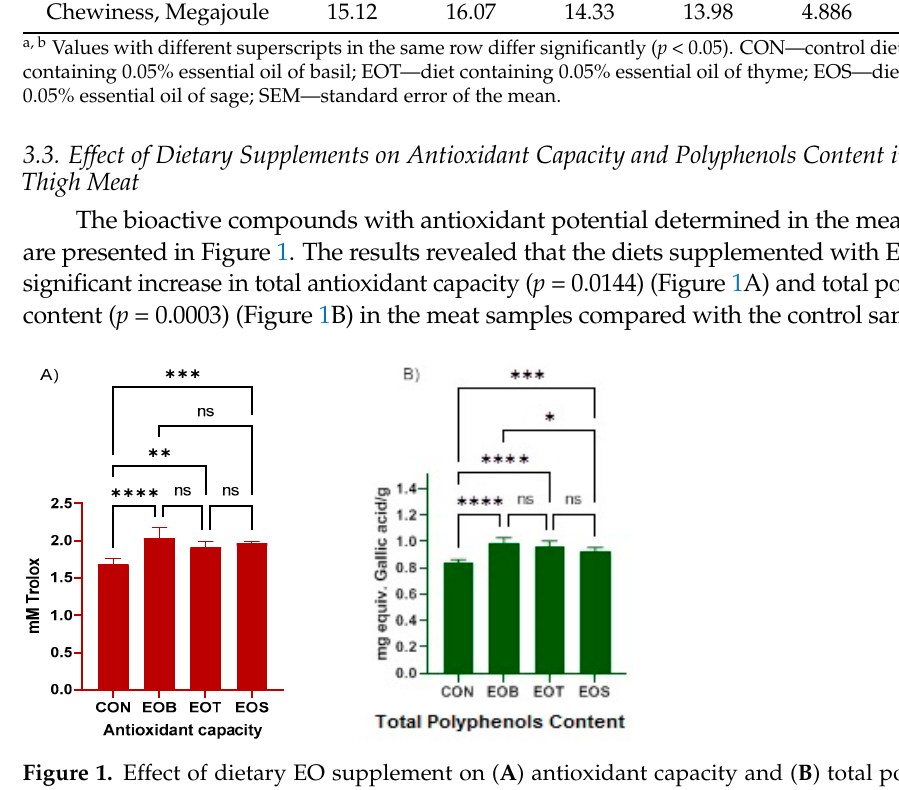
Figure 1. Effect of dietary EO supplement on ( A ) antioxidant capacity and ( B ) total polyphenols content determined in thigh meat samples. CON—control diet; EOB—diet containing 0.05% essen- tial oil of basil; EOT—diet containing 0.05% essential oil of thyme; EOS—diet containing 0.05% es- sential oil of sage; ns—not signi fi cant. * p < 0.05, ** p < 0.001, *** p < 0.0001, **** p < 0.00001.